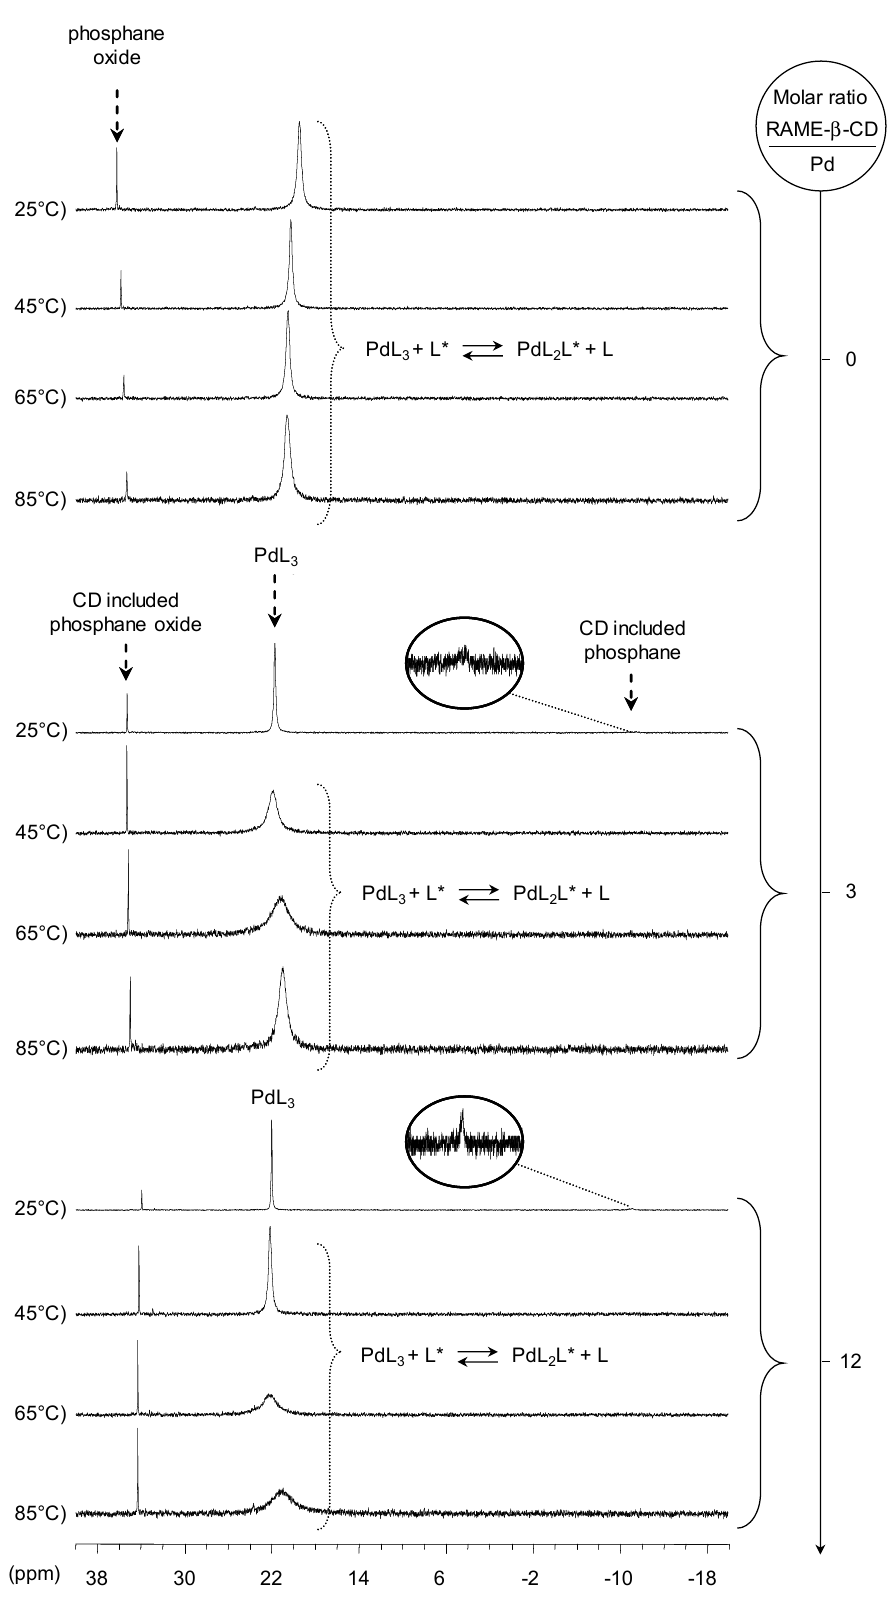
Figure 9. 31 P{ 1 H} NMR spectra of Pd(tris( p -Me)TPPTS) 3 depending on both temperature and RAME- β -CD quantity in D 2 O with a ligand concentration of 66 mM.